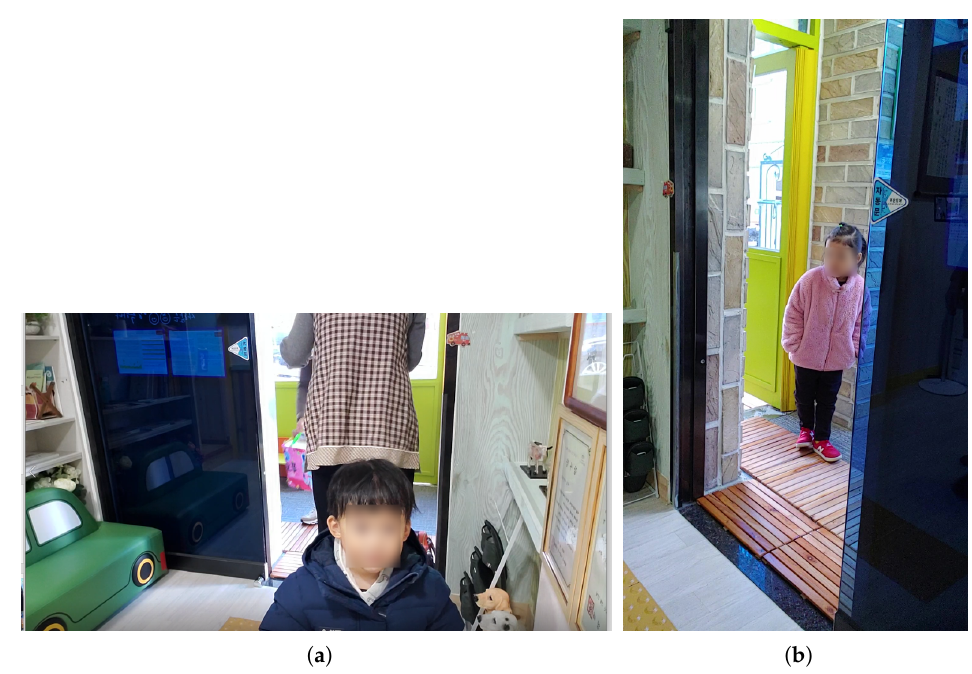
Figure 13. Actual captured images in Figure 12: ( a ) tablet PC; ( b ) smartphone.